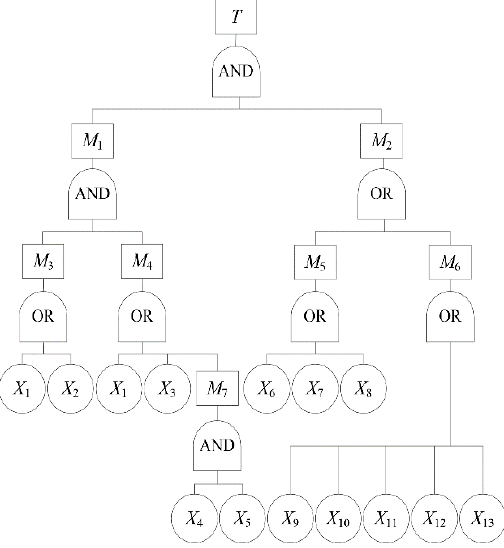
Figure 5. FTA of the flood disaster.